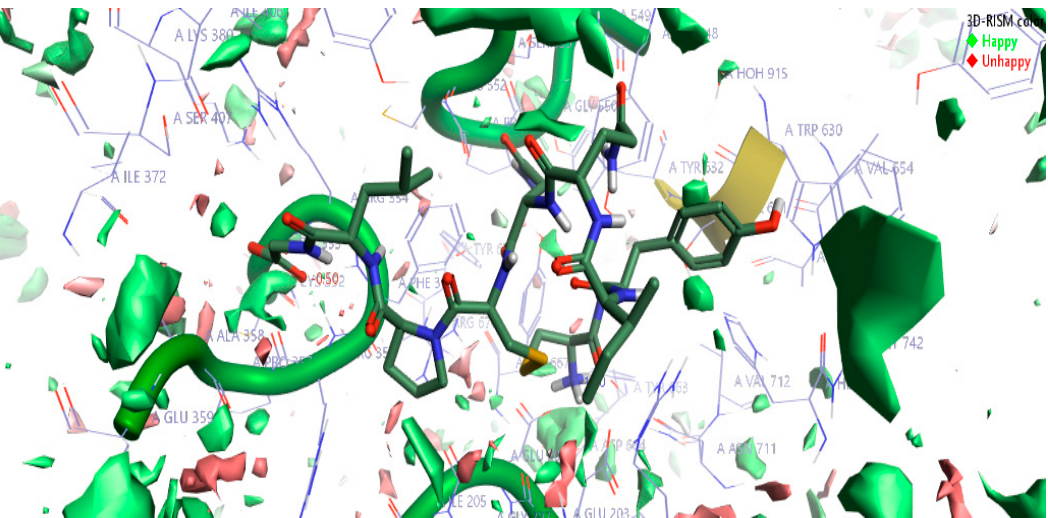
Figure 4. The stability of water molecules at the oxytocin bound to DPP4 protein calculated using the three-dimensional reference interaction model (3D-RISM). Free energy ( ∆ G) is colored in green for favorable water molecules and in red color for the unfavorable water molecules, calculated for the oxygen isodensity surface ρ = 5. Cresset visualization software was used to visualize the molecular insights of water molecules’ stability at the complex.